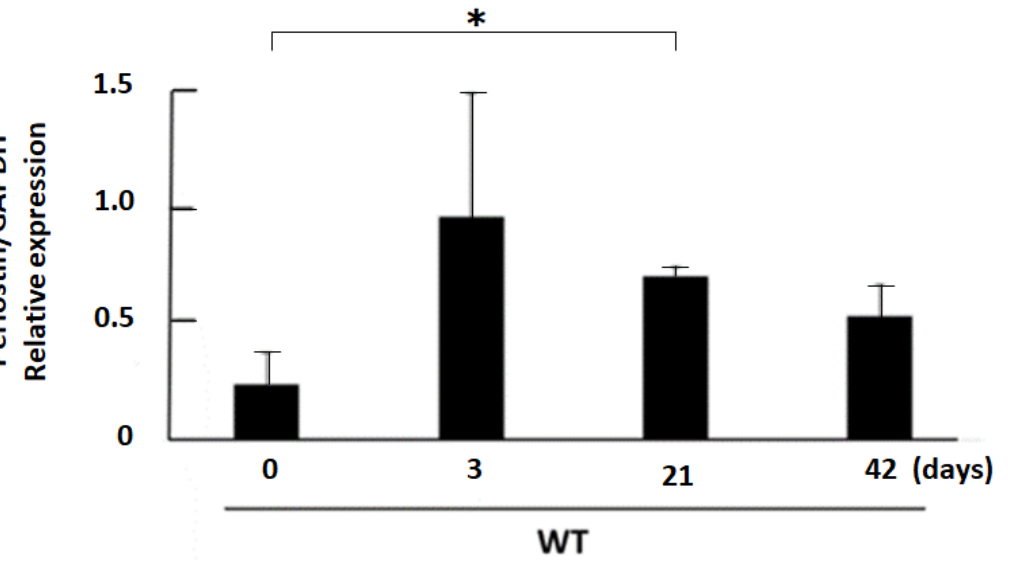
Figure 2. Periostin expression in the kidney of the rhabdomyolysis model. The expression of periostin in the kidney was highly increased, peaking at approximately day 3 after 50% glycerol injection. The relative gene expression was quantified at day 0–42 after operation by a real-time polymerase chain reaction using specific primers for periostin. * p < 0.05 vs. day 0. n = 3–4. Next, to elucidate the functional role of periostin in the rhabdomyolysis-induced acute kidney injury, we employed the rhabdomyolysis-induced acute kidney injury model in Pn-null mice. In the rhabdomyolysis, creatinine kinase was elevated from 4–6 h later from glycerol injection [28]. Serum creatinine kinase before injection and 6 h later from 50% glycerol injection, and creatinine at day 0 and day 3 after 50% glycerol injection were measured in wildtype and Pn-null mice. The levels of serum creatinine kinase was elevated in both WT and Pn-null rhabdomyolysis mice (Figure 3A). As shown in Figure 3B, in